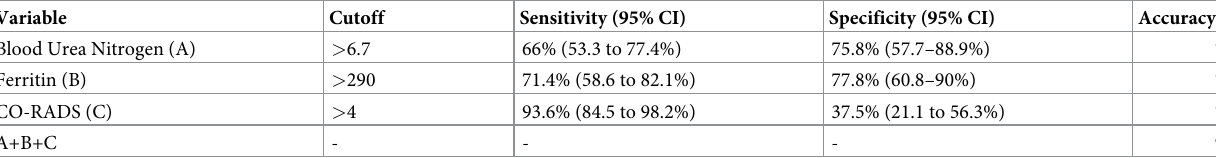
Table 6. Sensitivity, specificity and accuracy for the three factors derived from the ROC plot.